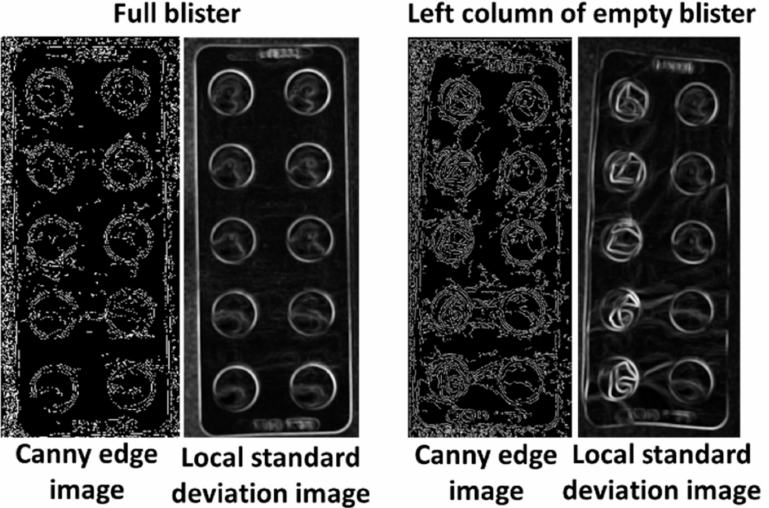
Figure 4. Intensity increase of local standard deviation and circle edge ratio due to deformation of pill